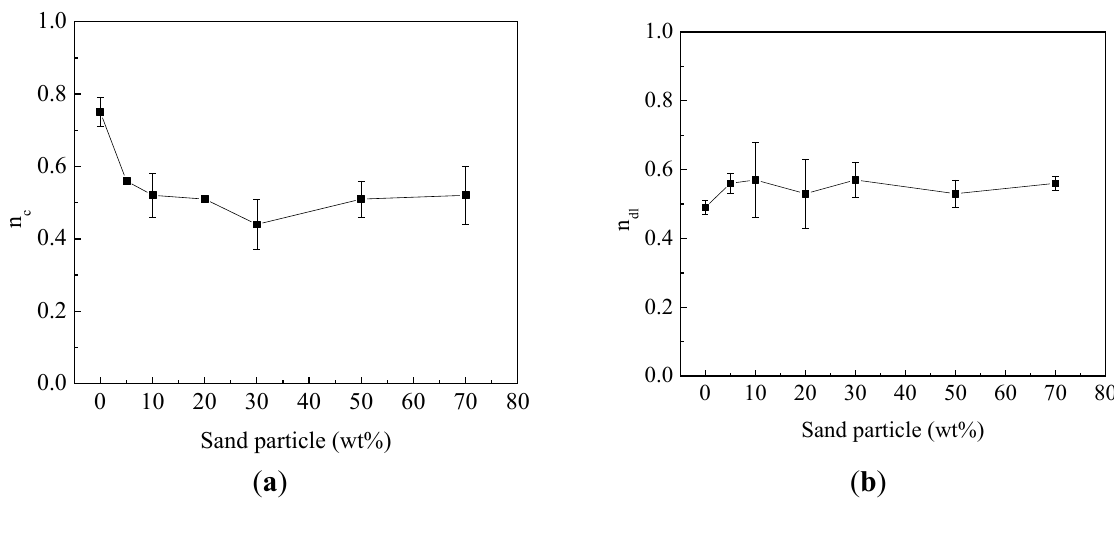
Figure 7. The effect of sand particle content on: ( a ) coating non-homogeneity; and ( b ) corrosion